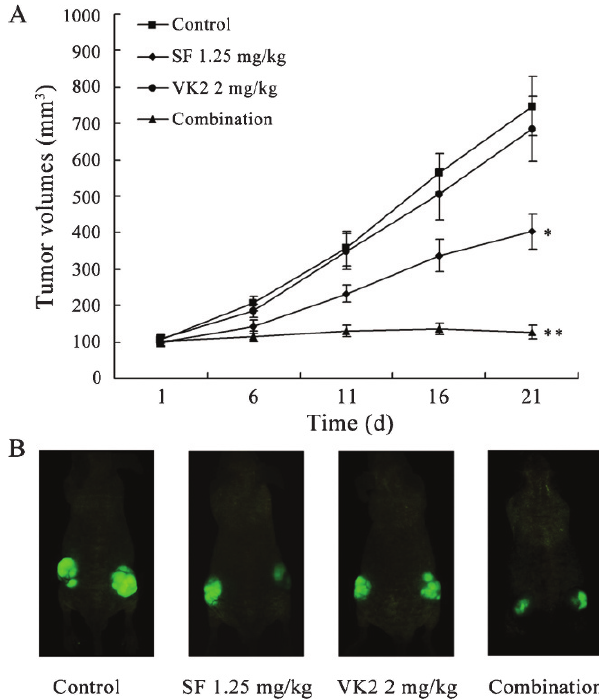
Figure 4 - Inhibition of tumor growth in vivo by the combination of sorafenib and VK2. (A) Tumor growth curve from nude mice transplanted with HepG2 cells and treated with sorafenib, VK2 or the two in combination. Each data point represents the mean tumor volume (in mm 3 ) ¡ SD of five mice (10 sites) per treatment. * p , 0.05 vs. control; ** p , 0.05 vs. treatment with sorafenib alone. (B) A representative mouse from each group using CRi imaging is